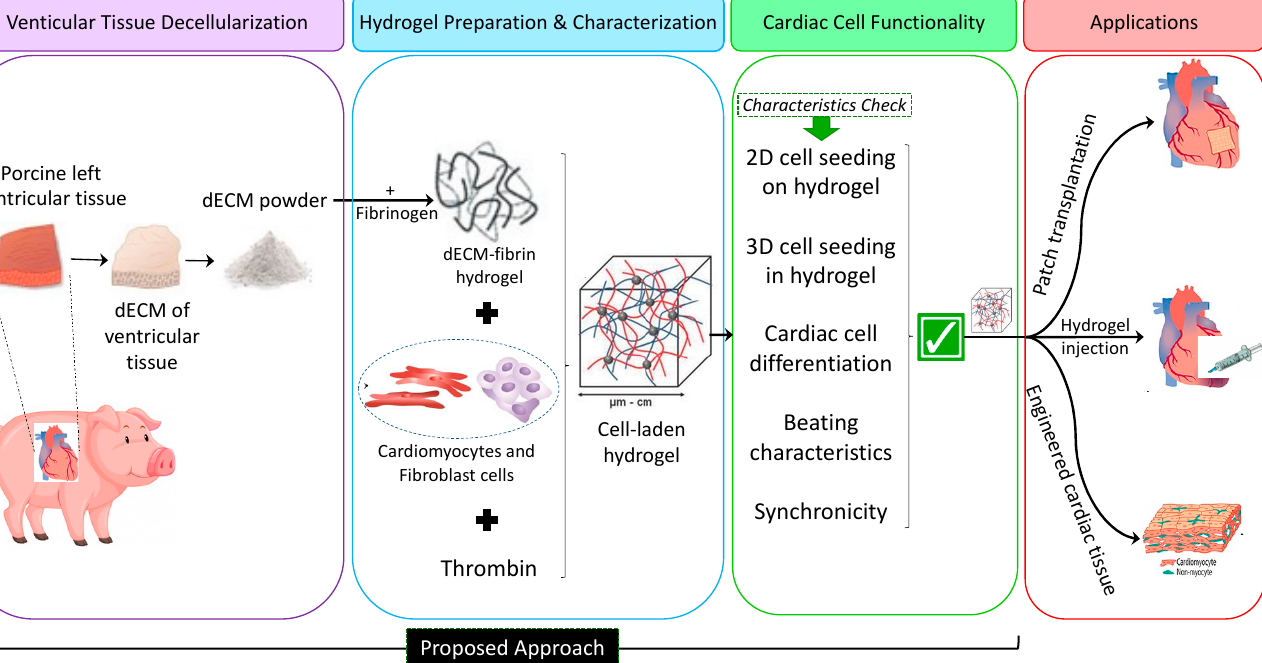
Figure 1. Flow diagram depicting the experimental approach in this study. Phase 1: dECM-fibrin hydrogel preparation, Phase 2: Characterization of the hydrogel. Phase 3: Investigating the functionality of cardiac cells in the hydrogel. The present study focuses on Phases 1 and 2.